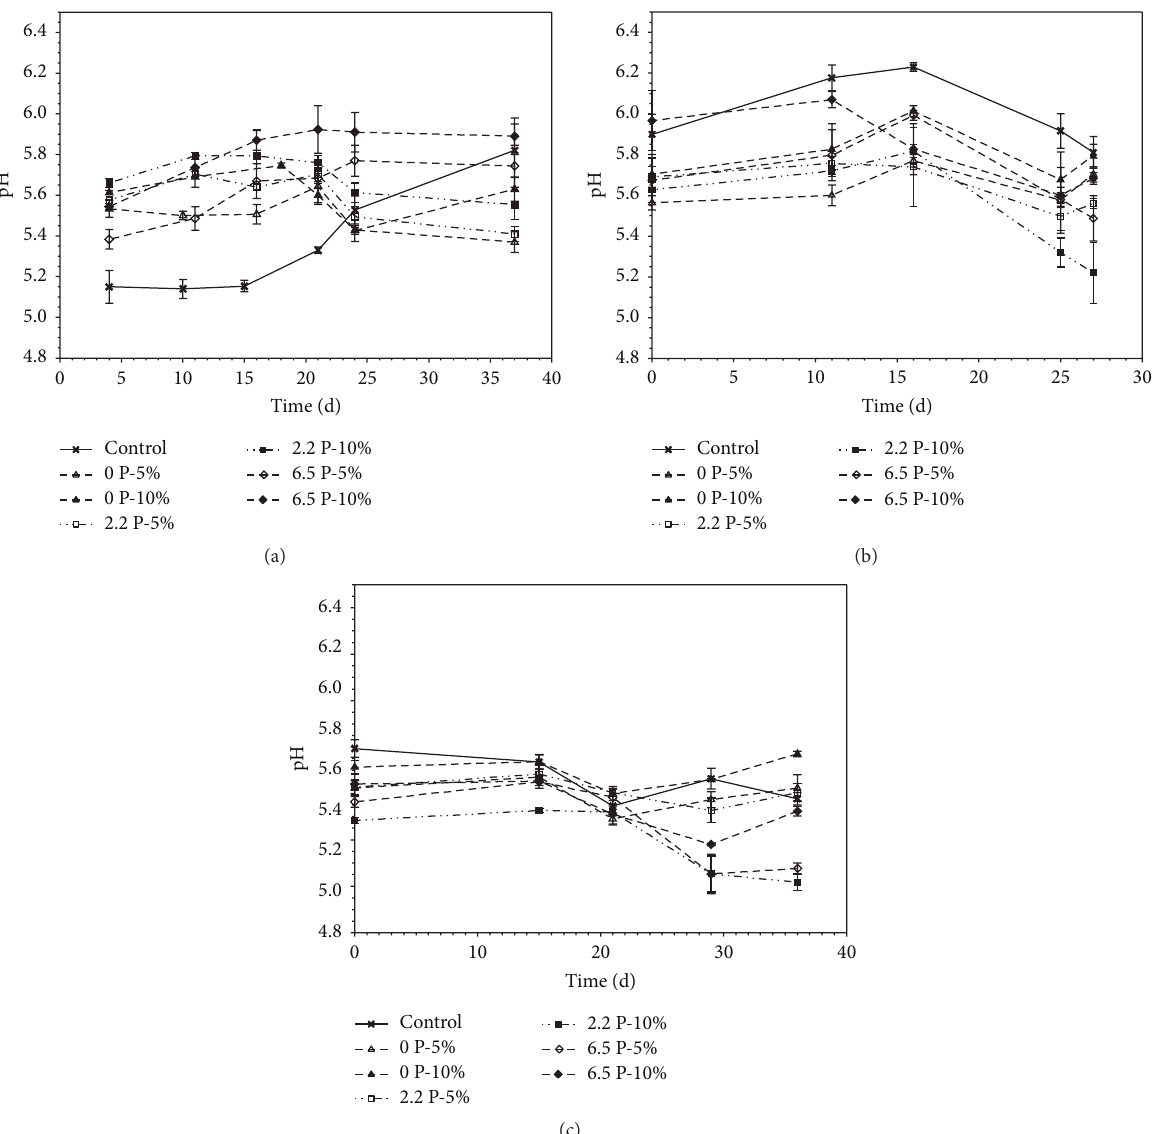
Figure 3: The pH of root media amended with no soil (control) and six soil treatment combinations containing 5 or 10% soil material (v :v) charged with 0, 2.2, or 6.5 mg ⋅ g −1 phosphate-P during the (a) first, (b) second, and (c) third of three successive tomato seedling crops. Bars indicate ± SE ( 𝑛 = 3 ). Lines connecting data points were included to aid in visualizing trends in the